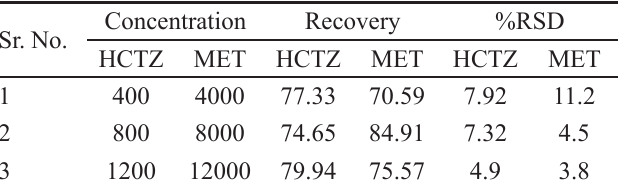
TABLE I - Result of recovery of hydrochlorothiazide and metoprolol tartarate in human plasma Sr. No.